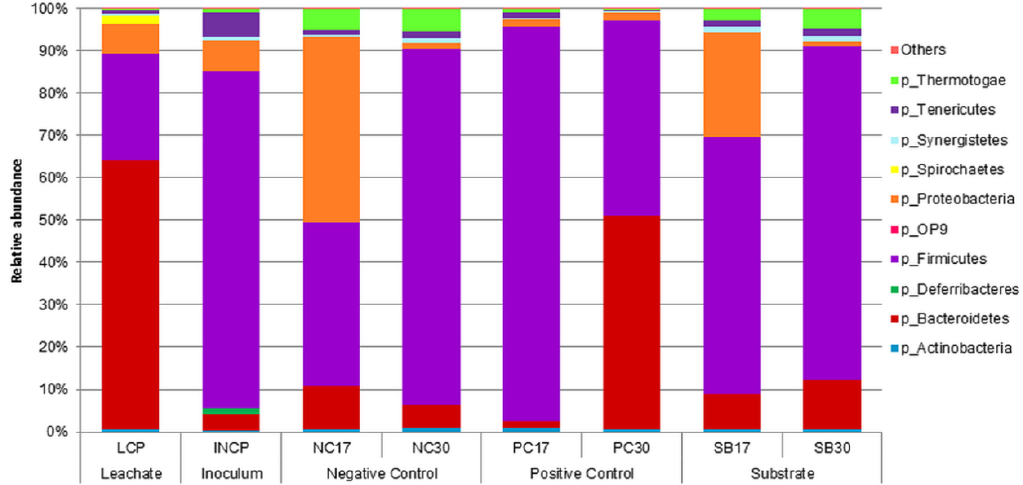
Figure 2. Relative abundance (%) of bacterial phyla in the leachate (LCP), inoculum (INCP; day 1), and treatment groups (NC — negative control; PC — positive control; SB — substrate; 17-on 17 days; 30-on 30 days).